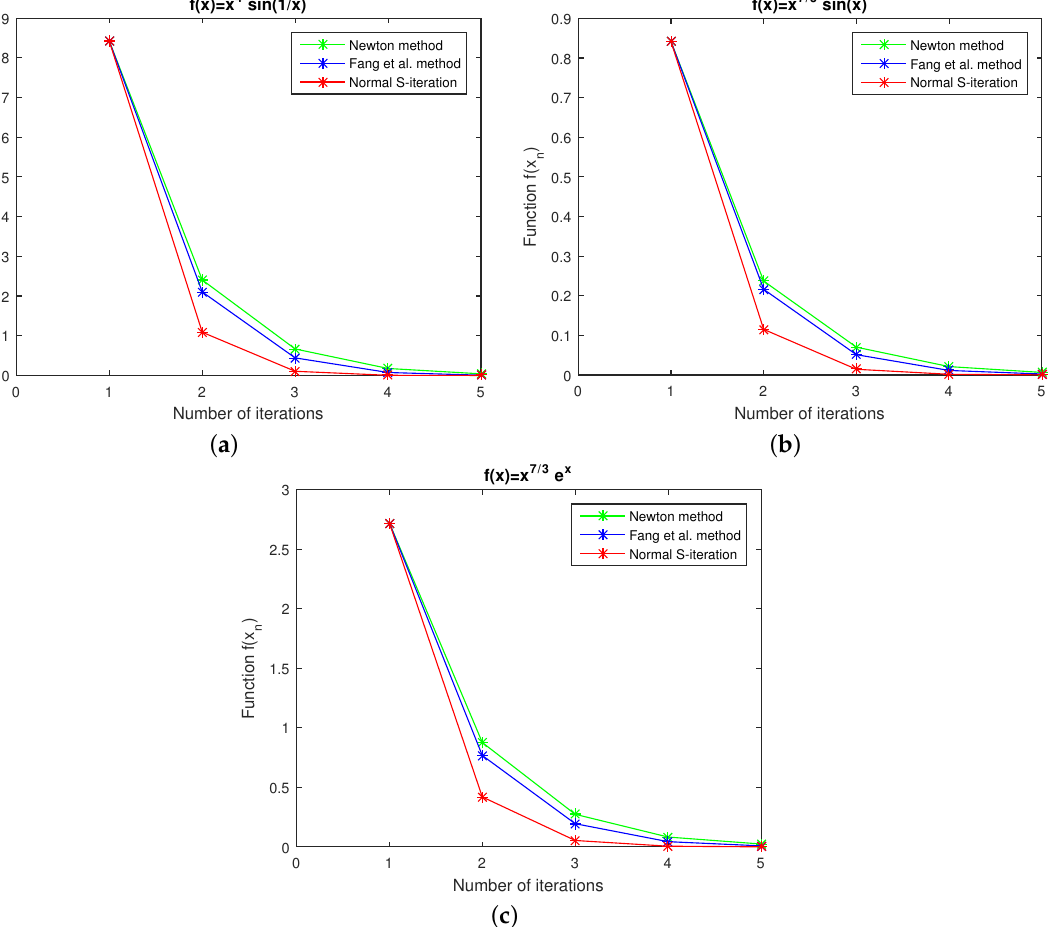
Figure 3. Graph for values of functions and numbers of iterations: ( a ) Graph for f 2 ; ( b ) Graph for f 3 ; ( c ) Graph for f 5